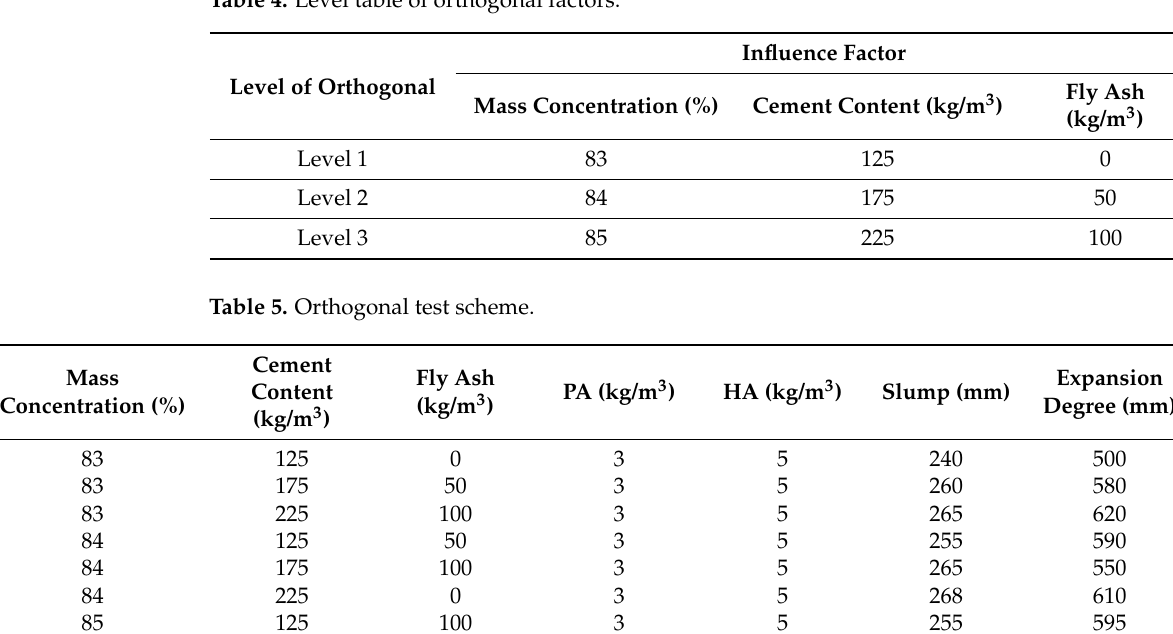
Table 4. Level table of orthogonal factors.